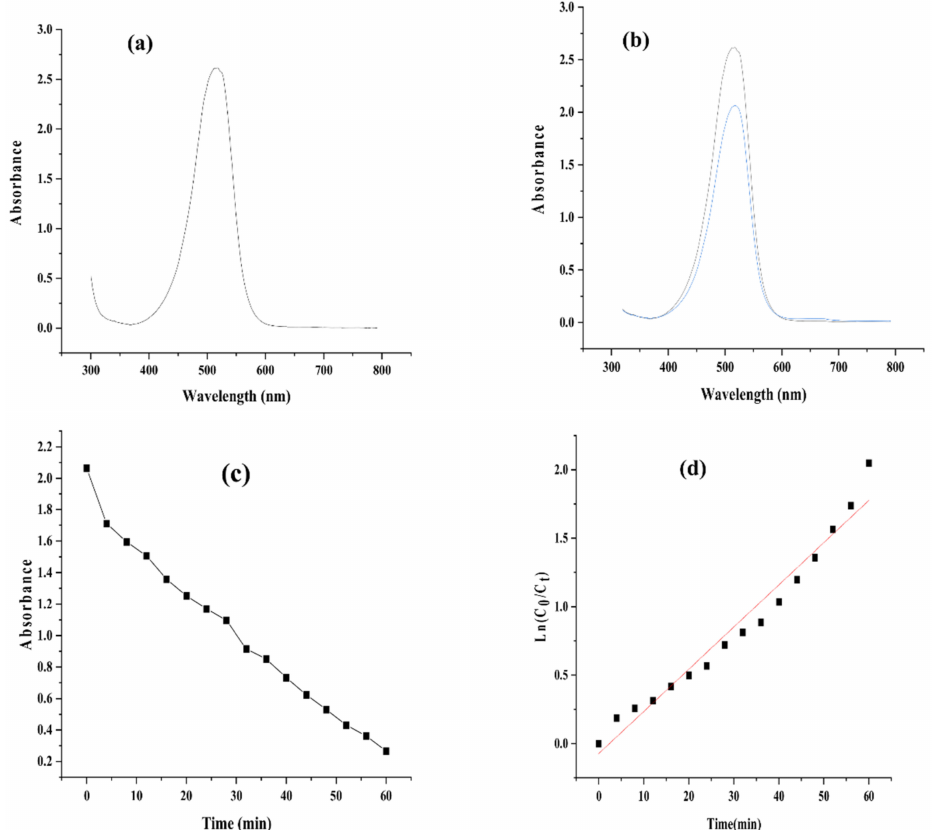
Figure 16. UV-Vis spectra of safranin O dye ( a ), UV-Vis spectra of safranin O after treating with NaBH 4 ( b ), degradation trend of safranin by passage of time ( c ), kinetically plotted graph between time and Ln (C o /C t ) ( d ).